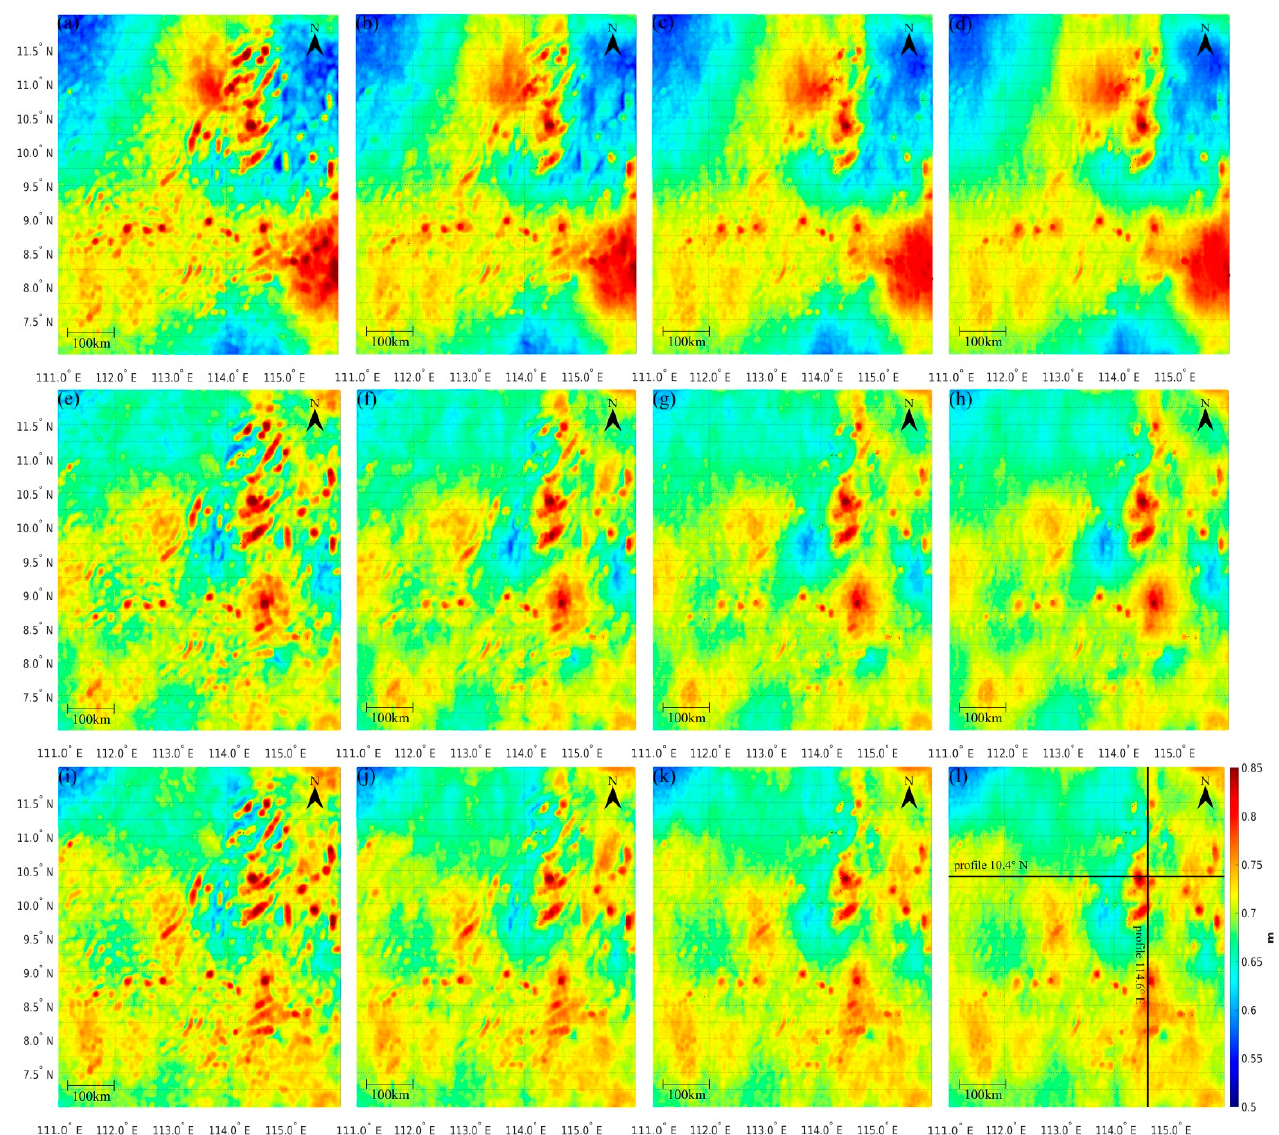
Figure 8. MDTs derived from various satellite altimeter-derived gravity models when different global geopotential models are used as the reference models. The first, second, and third rows are the solutions modeled when EGM2008, GECO, and SGG-UGM-1 are used as reference models, respectively. The first column ( a , e , i ) demonstrates the solutions modeled with different global geopotential models (up to the maximal d/o), the second column ( b , f , j ) manifests the solutions enhanced by HY2A, the third column ( c , g , k ) displays the solutions strengthened by SIO31, and the fourth column ( d , h , l ) shows the solutions augmented by DTU21GRA. The geographical coordinates are expressed in the Plate Carrée projection.